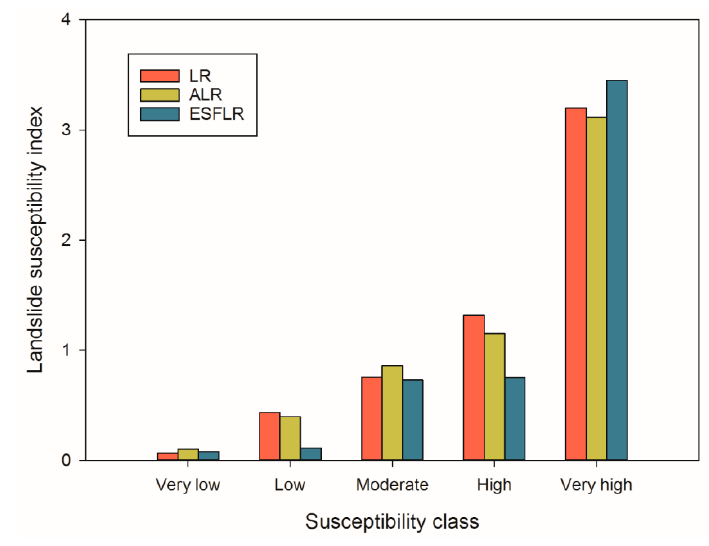
Figure 9. Landslide susceptibility index in susceptibility classes.